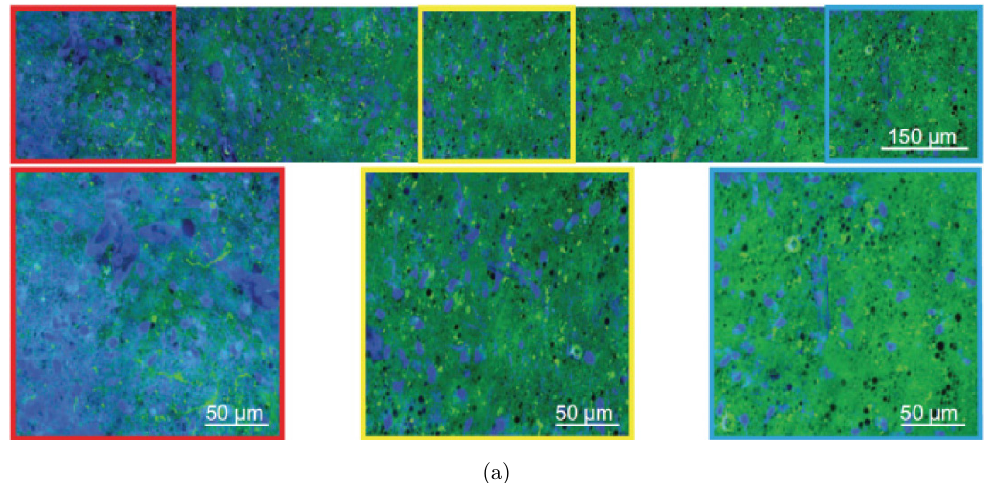
Fig. 7. SRS images showing brain tumor in¯ltrations: (a) Fresh human GBM brain tissue, and (b) frozen oligodendroglioma sections imaged with SRS and H&E.